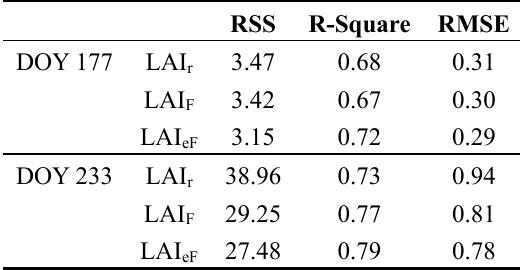
Table 3. Levels of precision of LAI r , LAI F , and LAI eF compared to LAI m on DOY 177 and